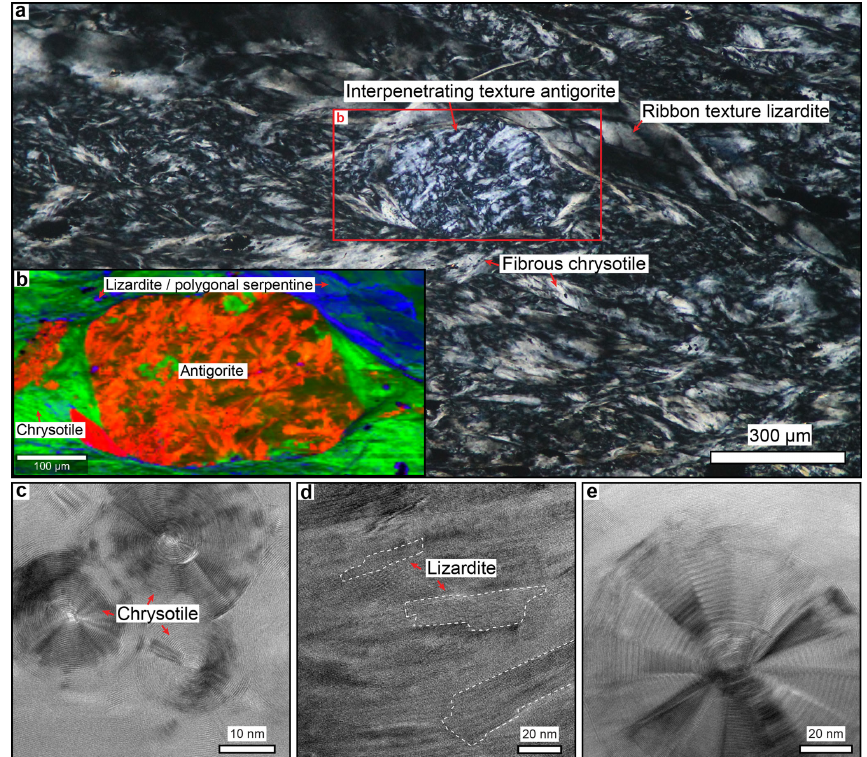
Figure 11. Raman and TEM characterisation of the scaly serpentinite fabric. (a) Representative thin section photomicrograph (crossed- polarised) of scaly serpentinite composed dominantly of chrysotile with ribbon-textured lizardite, with a porphyroclastic lens of antigorite showing an interpenetrating texture. (b) Submicron Raman spectroscopy map of the antigorite porphyroclast shown in panel (a) . The map highlights a central core of antigorite (red) that is breaking down to chrysotile (green) and lizardite–polygonal serpentine (blue). The por- phyroclast is elongate: margins subparallel to the scaly foliation are truncated by lizardite–polygonal serpentine-rich seams or aggregates, whereas fibrous chrysotile grows in “beards” from the ends of the porphyroclast. (c) TEM image of chrysotile-fibre cross sections. (d) TEM image of laths of lizardite. (e) TEM image of a polygonal serpentine cross